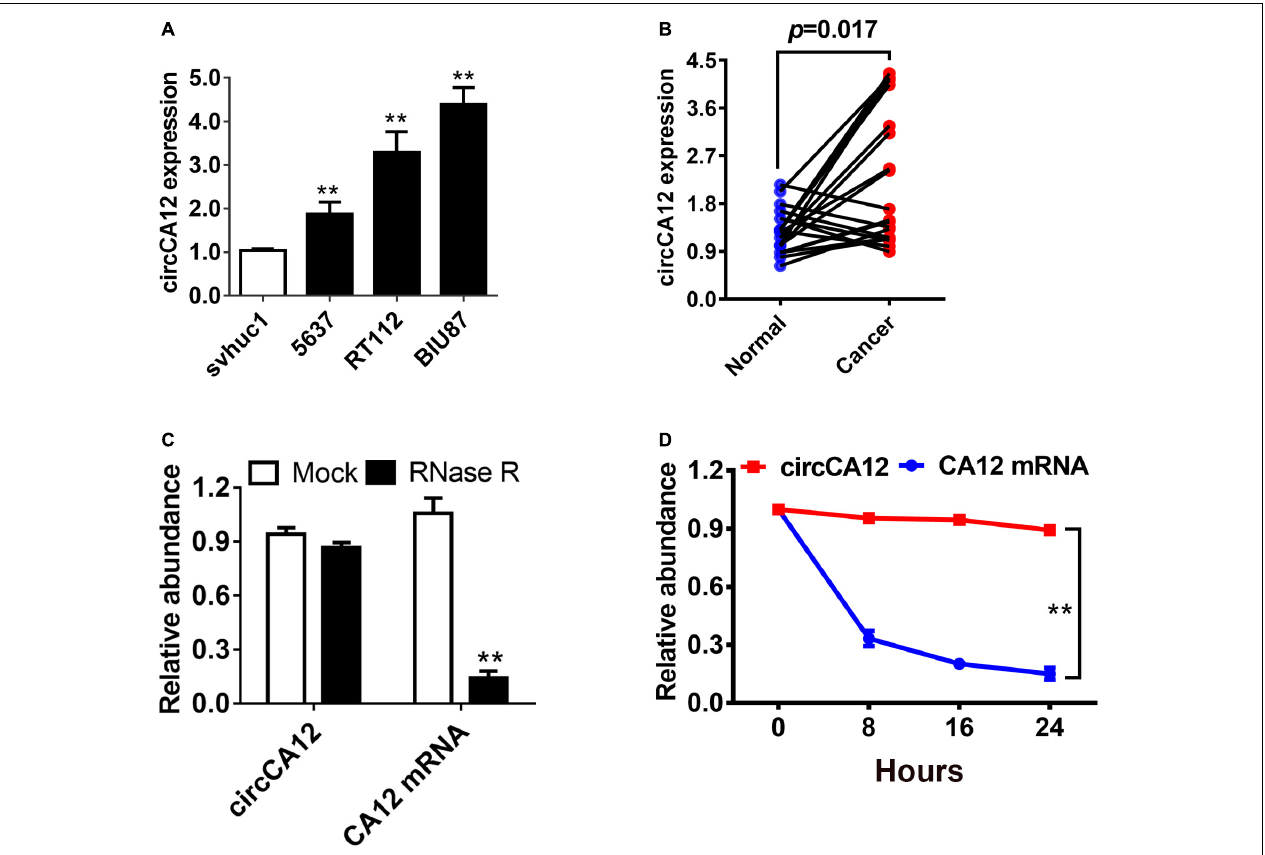
FIGURE 1 | Differential expression and circular characterization of circCA12 in bladder cancer. (A) circCA12 relative expression in non-malignant bladder epithelial cells and bladder cancer cell lines. (B) circCA12 differential expression was verified in 20 bladder cancer tissues and paired non-malignant tissues. (C) qRT-PCR assessment of circCA12 and CA12 mRNA in BIU87 cells after RNase R treatment. (D) qRT-PCR assays of circCA12 and CA12 mRNA in BIU87 cells after Actinomycin D treatment. ** P <